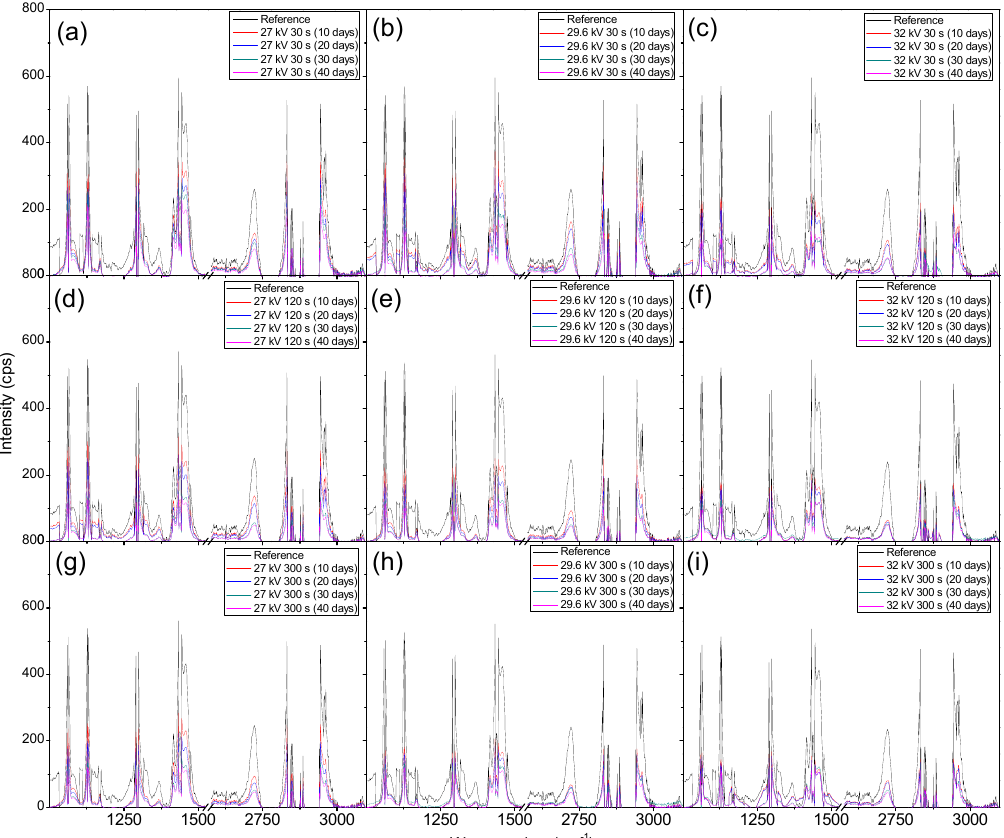
Figure 14. Raman spectroscopy measurements of LDPE after their introduction into the bacterial broth to obtain biodegradation to determine the impact ≈ 4% CO 2 had in the plasma discharge. ( a – i ) show how exposure time and applied voltage during plasma treatment impact the degradation process of LDPE. ( a – c ), ( d – f ), and ( g – i ) show how the changes in voltage impact the degradation of LDPE while maintaining a constant treatment time. ( a , d , g ), ( b , e , h ), and ( c , f , i ) show how the changes in treatment time impact the degradation of LDPE while maintaining a constant applied voltage.